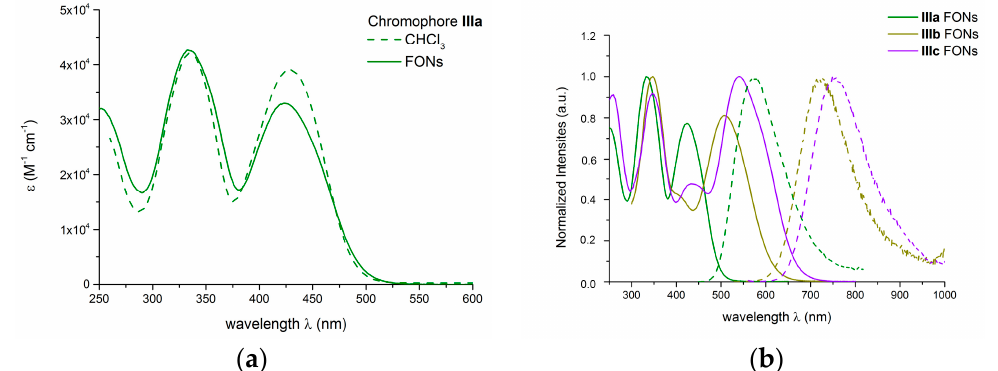
Figure 4. ( a ) Comparison of the absorption spectra of dye IIIa as isolated chromophore dissolved in CHCl 3 and as chromophoric subunits in FONs; ( b ) Comparison of absorption (solid line) and emission (dashed line) spectra of FONS made from dyes IIIa , IIIb and IIIc in water.